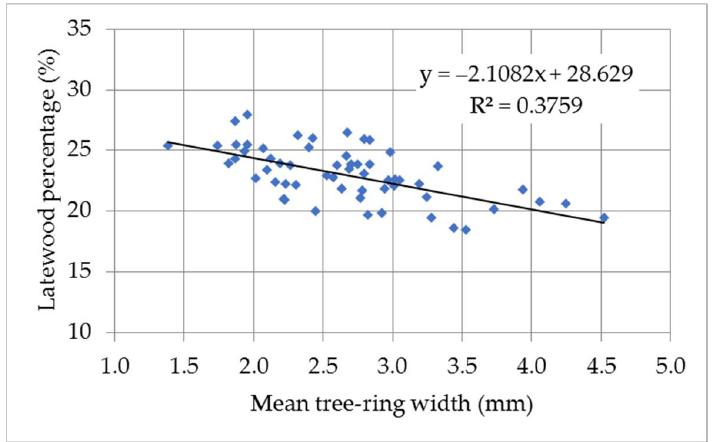
Figure 9. Relationship between latewood percentage and mean ring width of tested spruce logs.